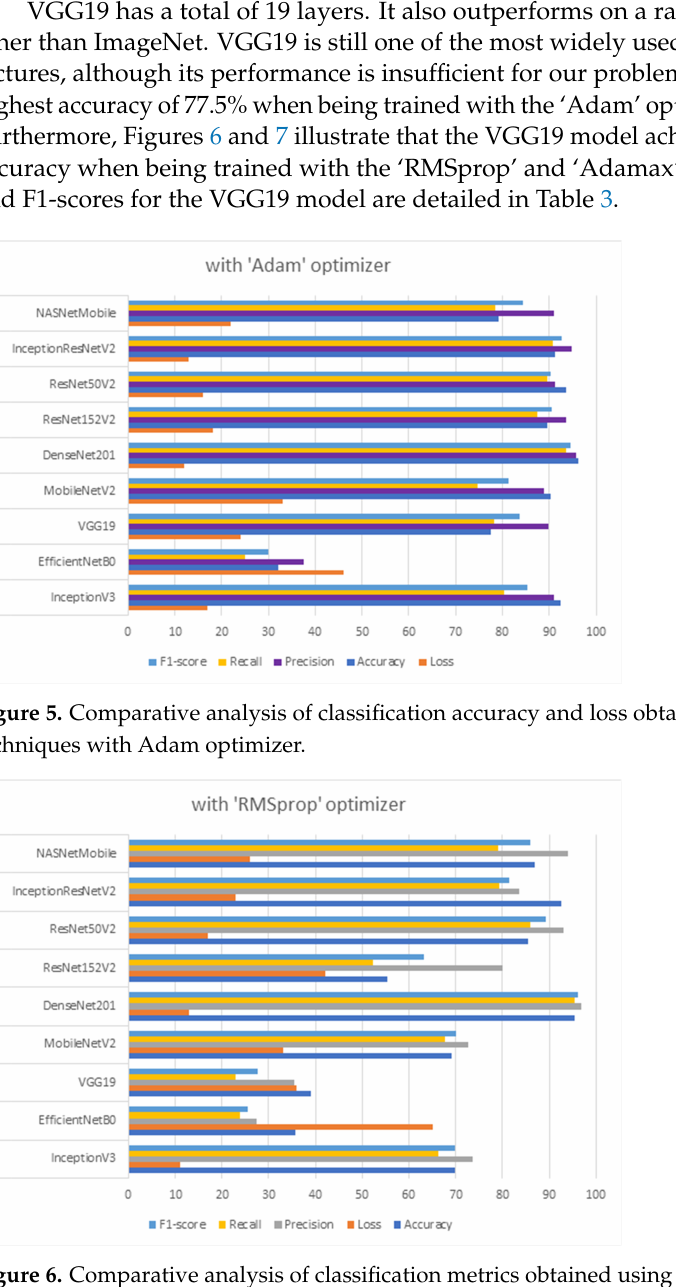
Figure 6. Comparative analysis of classification metrics obtained using transfer-learning techniques with RMSprop